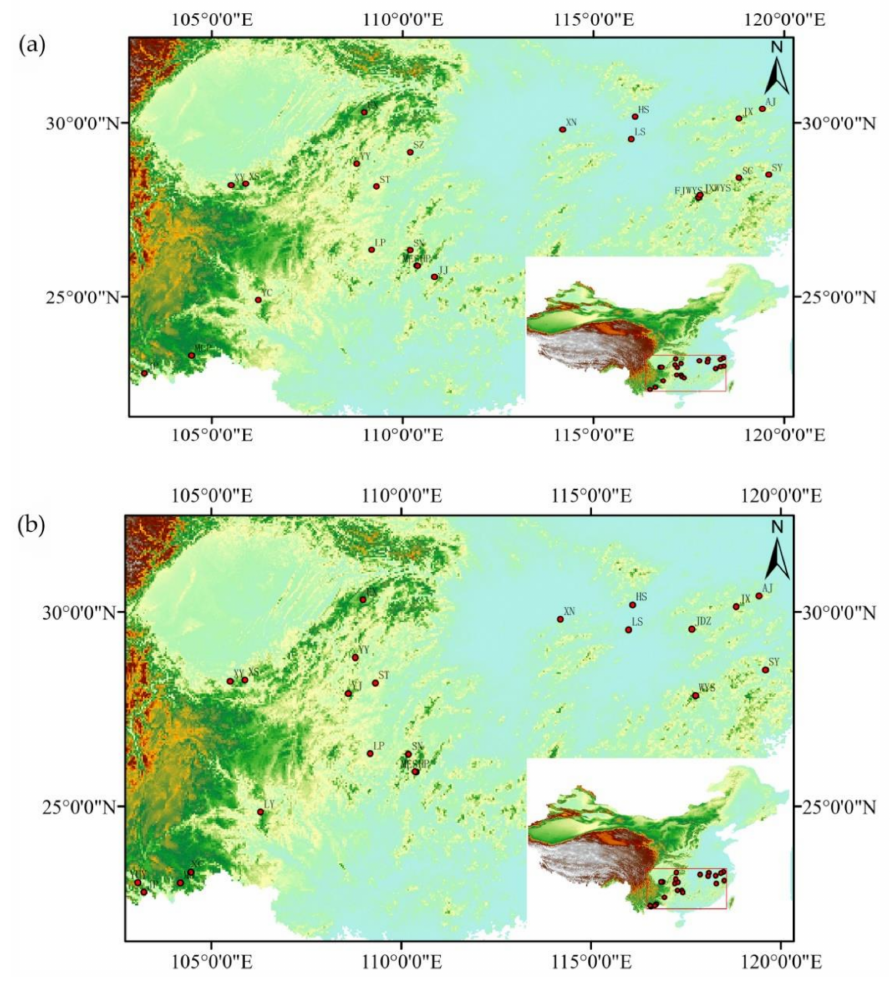
Figure 1. Sample location distribution of L. chinense . ( a ) cpDNA and nrDNA from 23 populations. ( b ) Six nuclear genes from 23